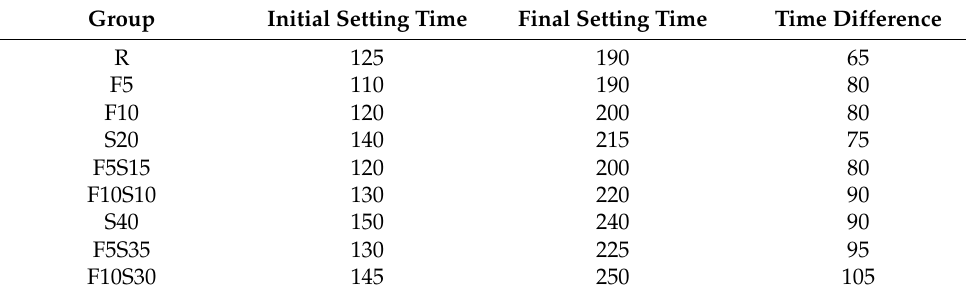
Table 3. Effect of binders on the setting time